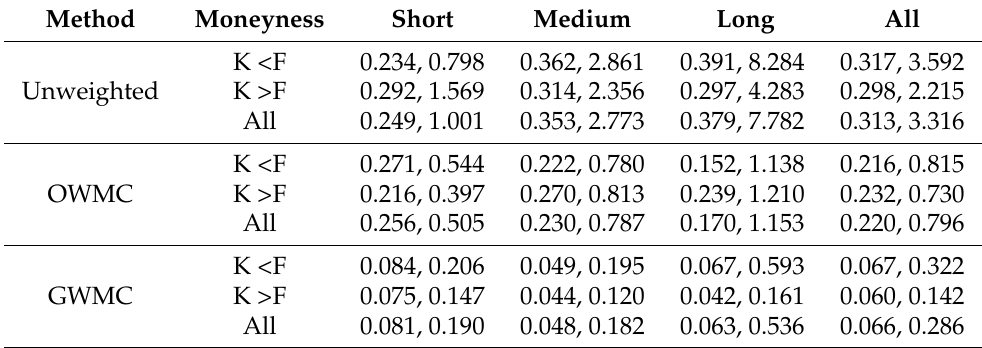
Table 3. Cross-sectional results for the unweighted version, the OWMC method, and the GWMC method using the Heston model as an initial model, for OTM puts (K <F) and OTM calls (K >F). The first and second numbers in each column are the MRPE and MAPE, respectively.